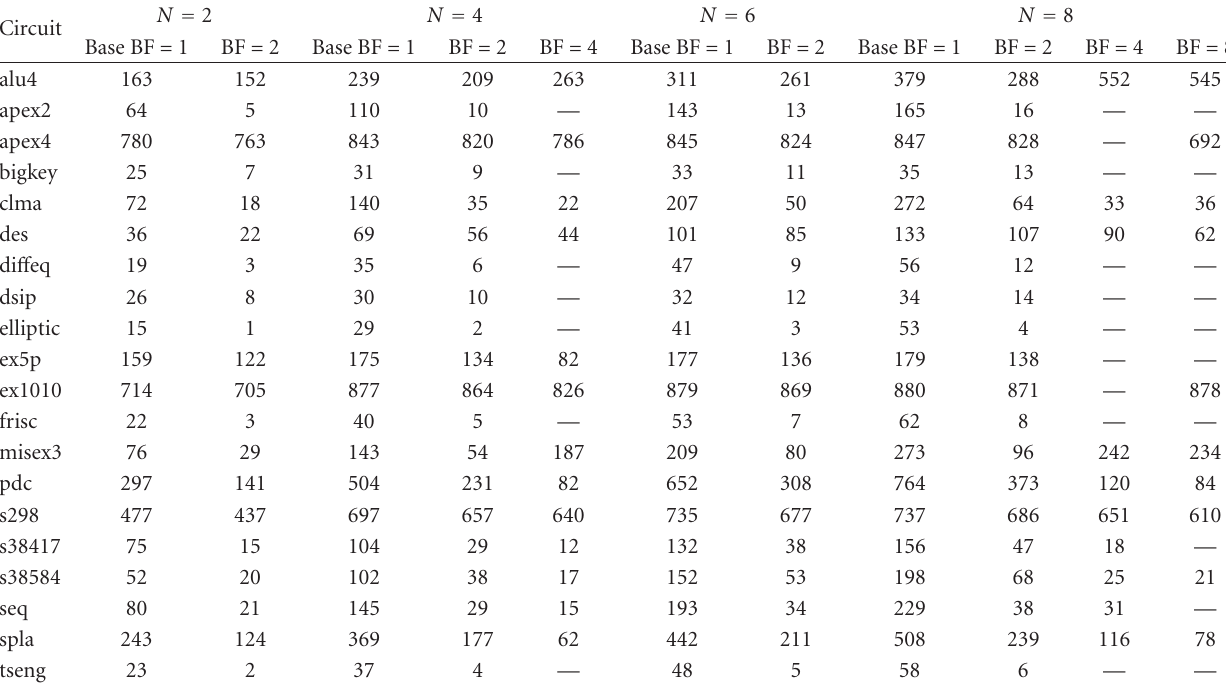
Table 4: Number of LUTs packed into memory blocks ( B =